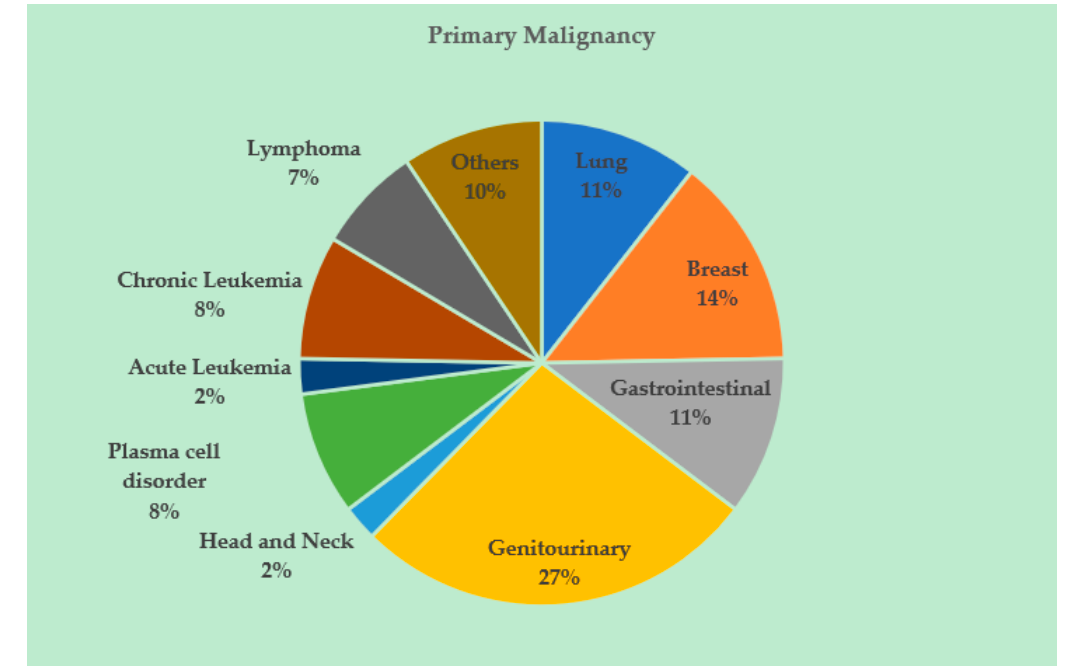
Figure 1. Distribution of the type of primary malignancy in the study population, n = 85 [Other cancers included cutaneous squamous cell cancers (n = 2), cutaneous melanoma (n = 1), sebaceous cell carcinoma (n = 1), leiomyosarcoma (n = 1), bone sarcoma (n = 1), glioblastoma multiforme (n = 1), and cancer of unknown primary (n = 1)].